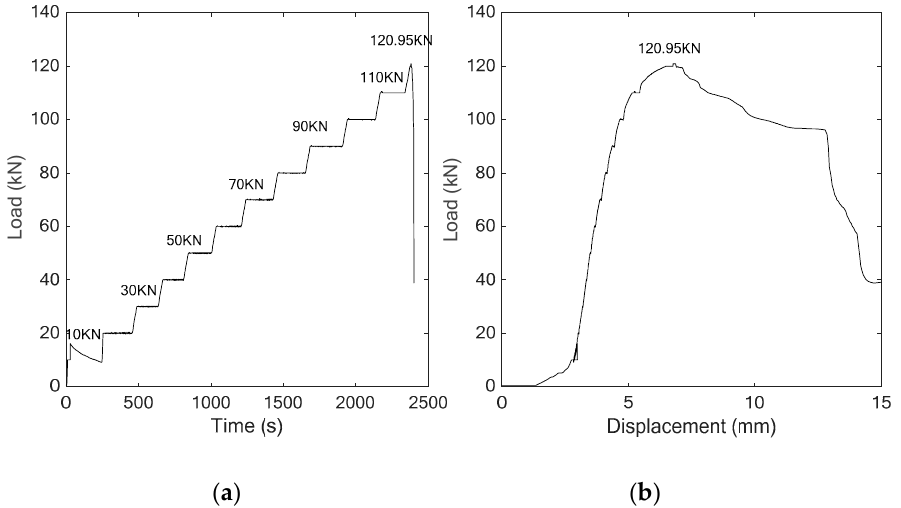
Figure 14. The curves of ( a ) Time vs. load, ( b ) Displacement vs. Load.